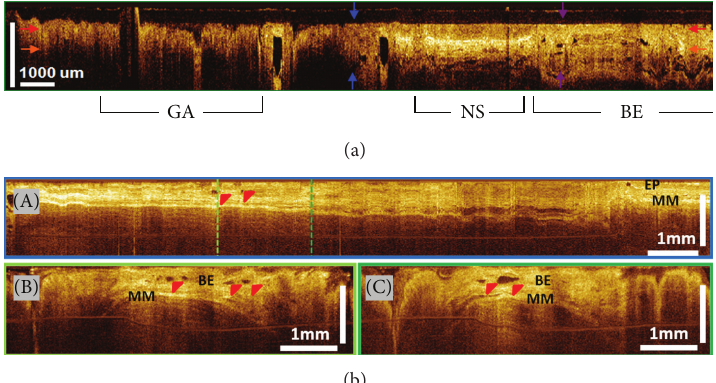
Figure 2: Barrett’s esophagus (BE) without dysplasia. (a) Cross-sectional OCT imaging showing clear differences in layered architecture between gastric (GA), normal squamous (NS), and BE regions. BE regions exhibit distortion of the layered architecture and abnormal glandular features. (b)Cross-sectionalOCTimages aroundGEJ. BEglands(redarrows)areclearly observed (EP:epithelium; MM:muscularis mucosae in photos A–C).